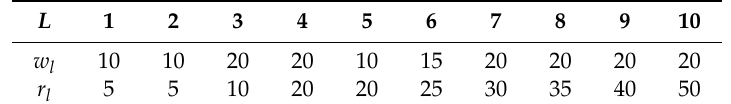
Table 2. Lot data for Example 1.